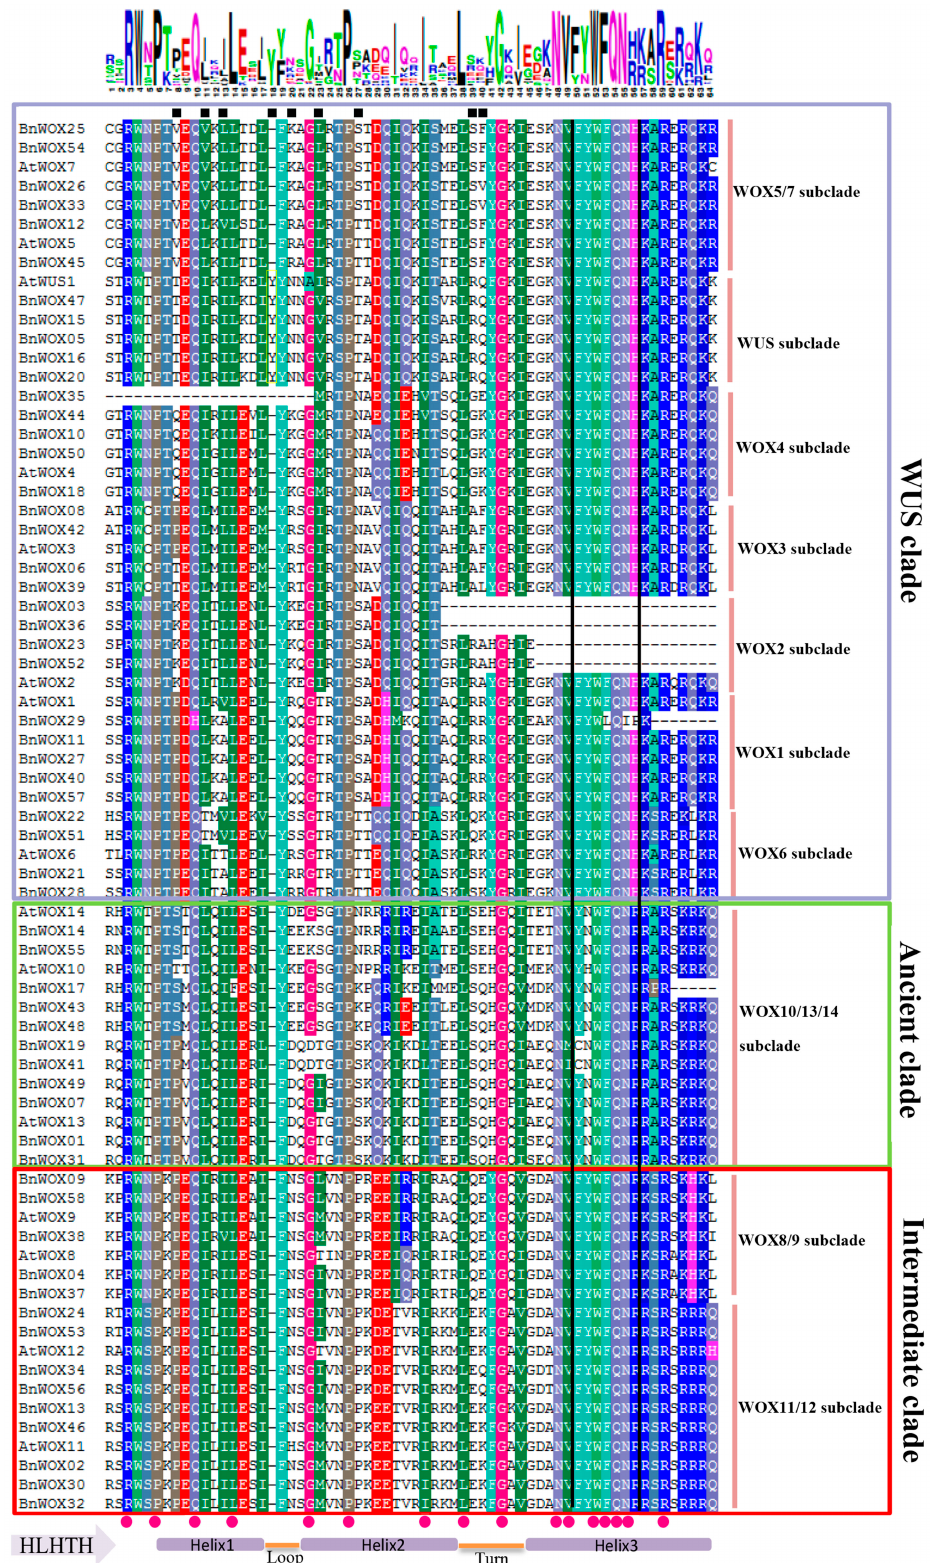
Figure 2. Homeodomain sequence analysis in WOX proteins from B. napus and Arabidopsis . The sequence logos are based on the alignments and the WOX family members contain the typical helix–loop–helix–turn–helix structure. Completely conserved residues are represented by red dots and WUS subclade-specific residues are indicated by black squares. Black boxes indicate marker sequences for the clades and green, red and purple boxes show the ancient, intermediate and WUS clades, respectively, with subclades. The conserved Y residue insertion at the 18th position is also